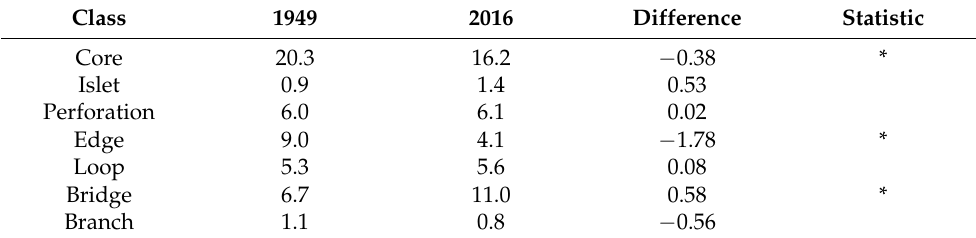
Table 3. Average patch size (ha) of built-up areas by morphological class and year (difference was calculated as annual per cent change over time; statistics is the level of probability associated with a non-parametric Mann Whitney U-test checking for similarity in patch size over time; * indicates significant differences at p < 0.05 after Bonferroni’s correction for multiple comparisons).